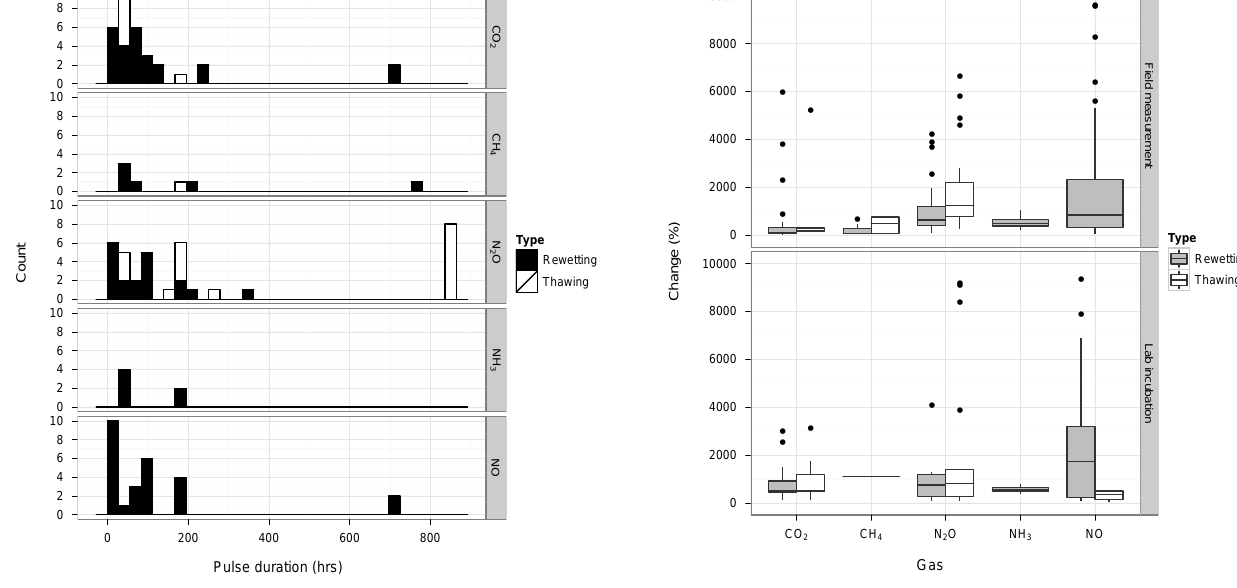
Fig. 3. Histograms of the duration of increased flux of soil gas CO 2 , CH 4 , N 2 O, NO and NH 3 following soil rewetting and thawing in field and laboratory experiments.